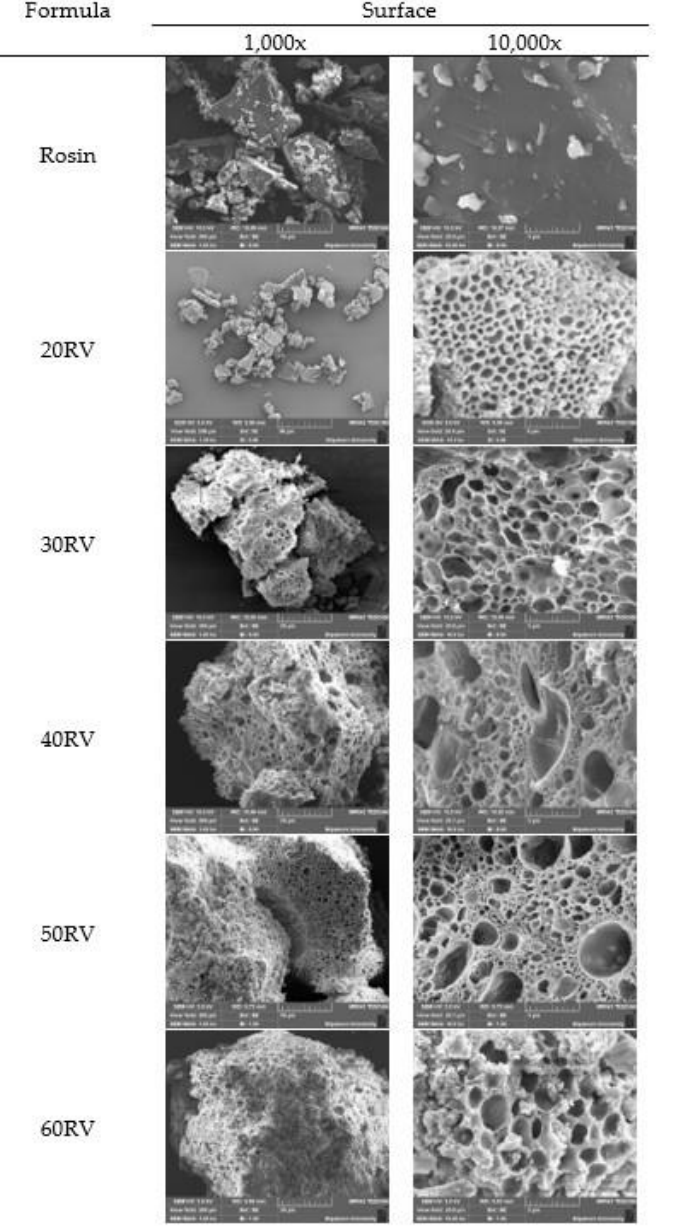
Figure 6. SEM micrographs of the surface of rosin and the vancomycin HCl-loaded ISG formulations at 1000× and 10,000×.